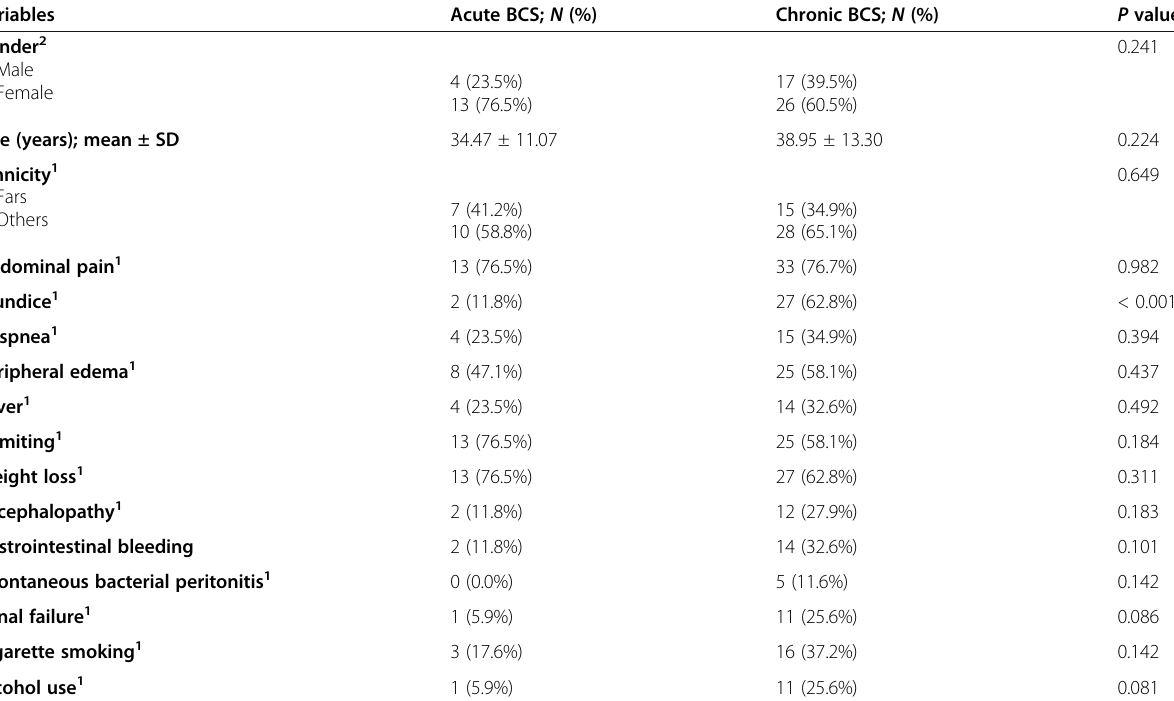
Table 2 Comparison of clinical and demographic characteristics between acute ( n = 17) and chronic ( n = 43) Budd – Chiari syndrome